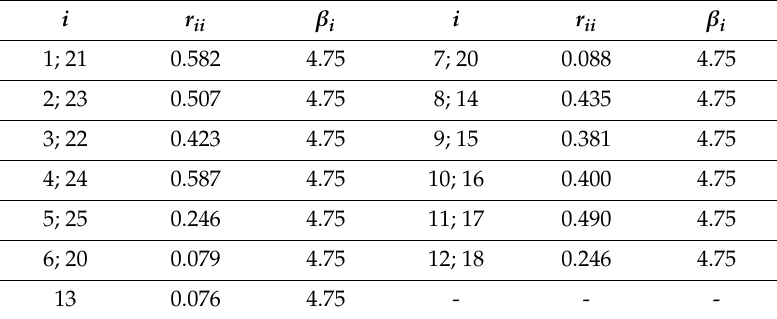
Table 3. Redundancy contributions ( r ii ) and reliability indexes ( β i ) for components of variant